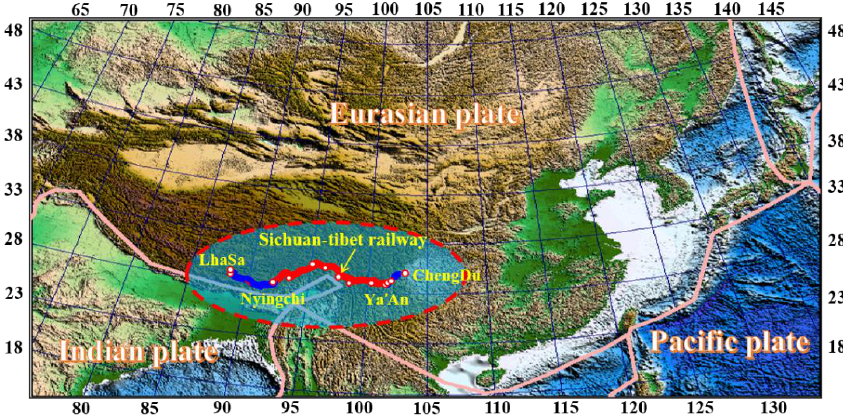
Figure 1. Plate distribution along the Sichuan–Tibet railway.